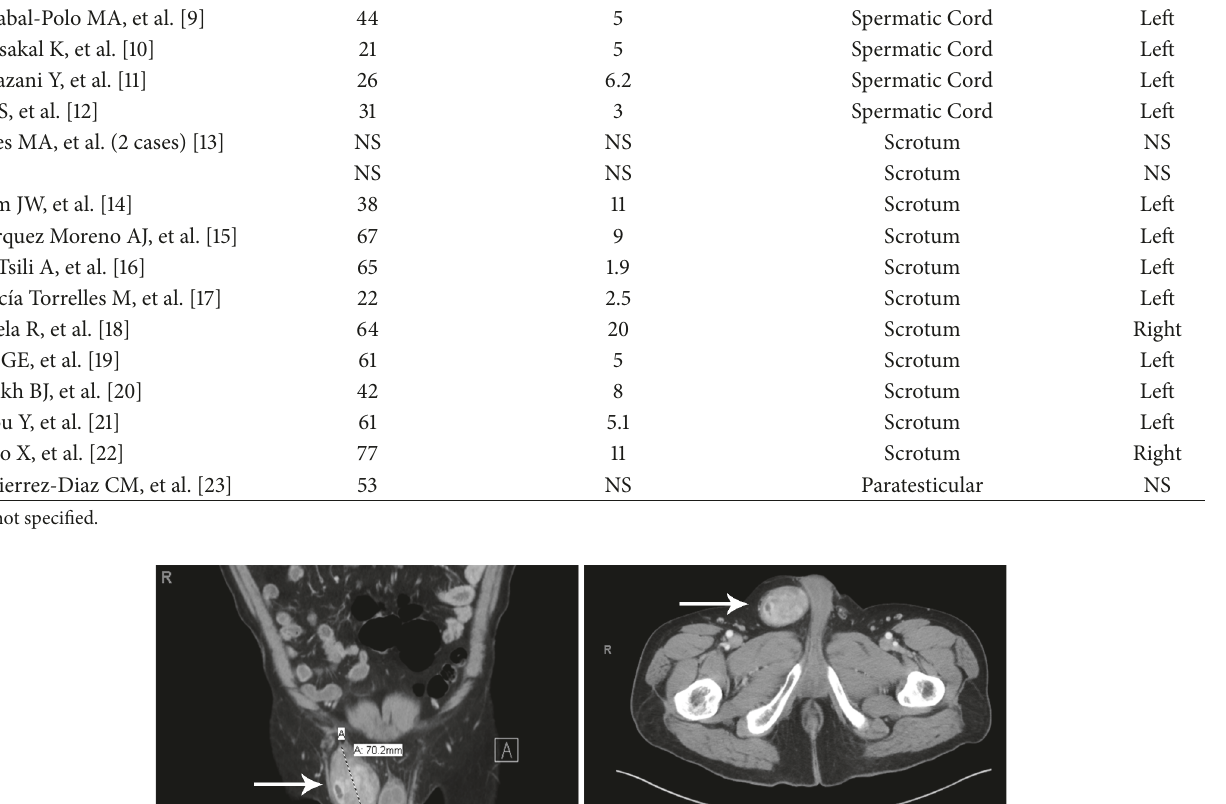
for evaluation. Macroscopically, the mass weighed 67.5 grams and measured 7 x 5.5 x 2.5 centimeters. Its outer surface was smooth, pink/white in color and covered by a thin membrane. The cut surface of the mass was white and